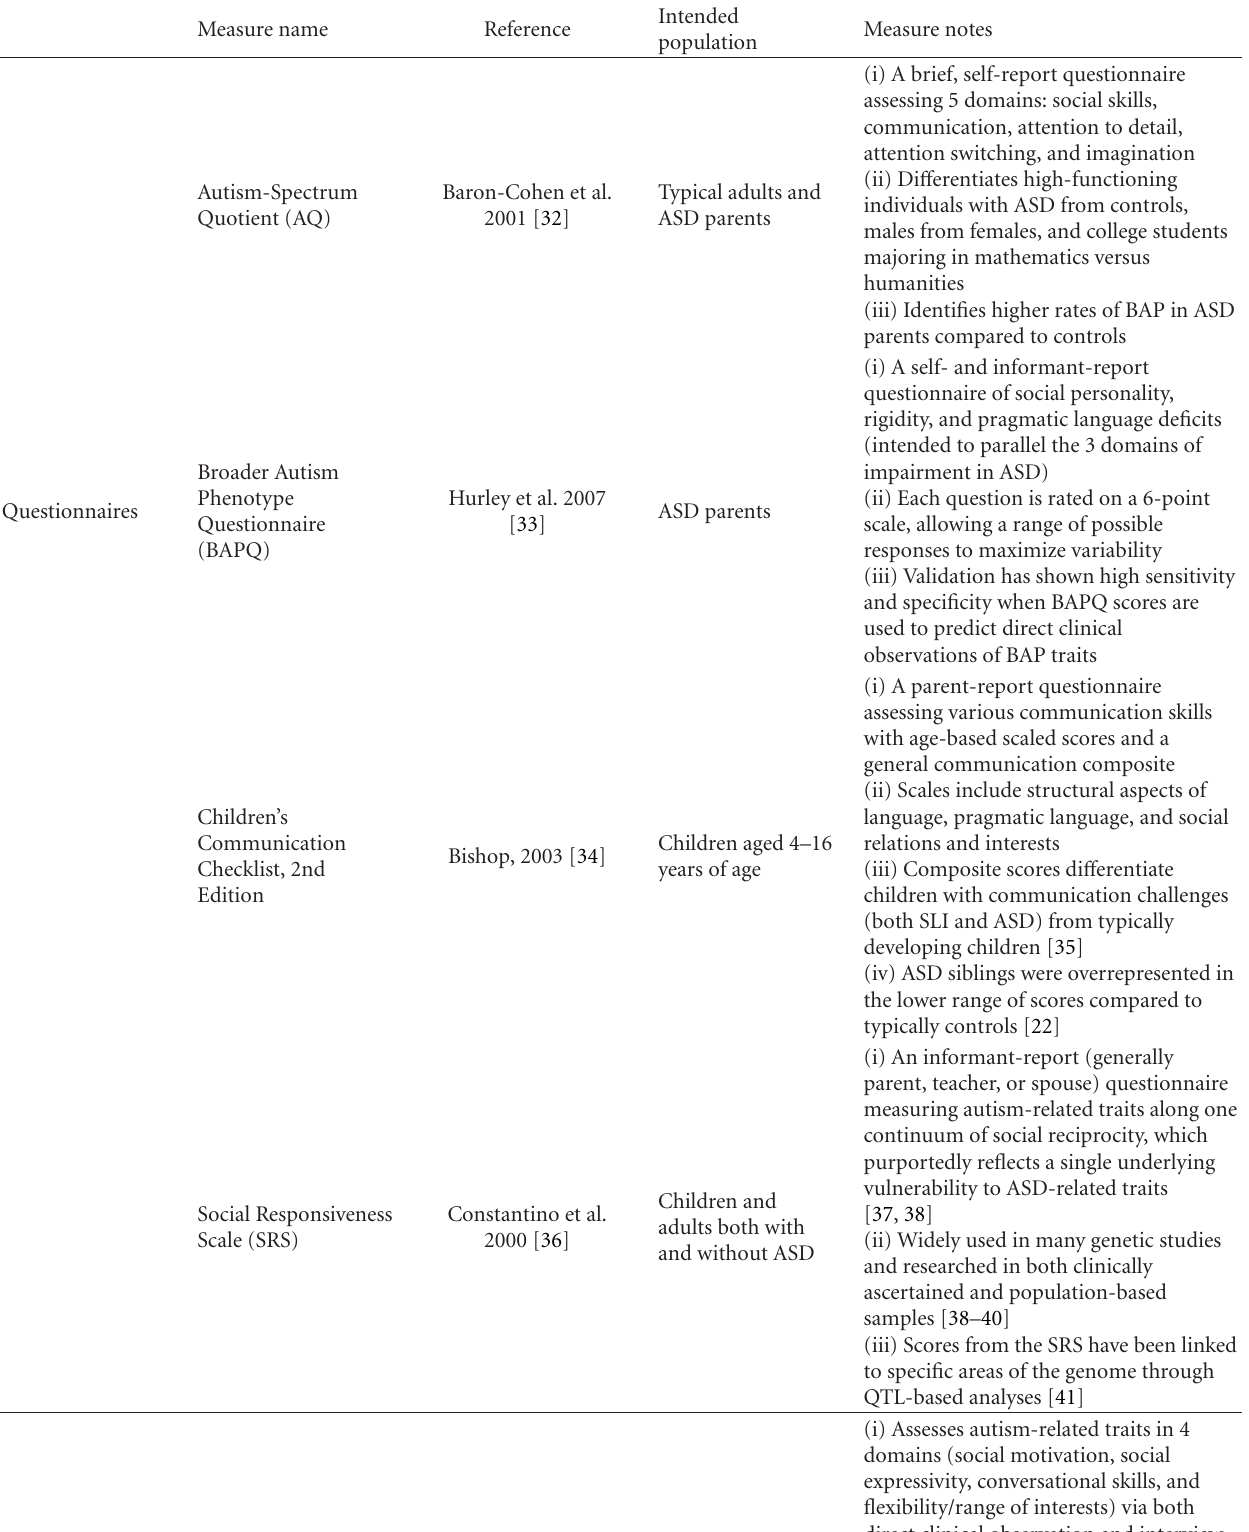
Table 2: Measures developed and utilized to assess the